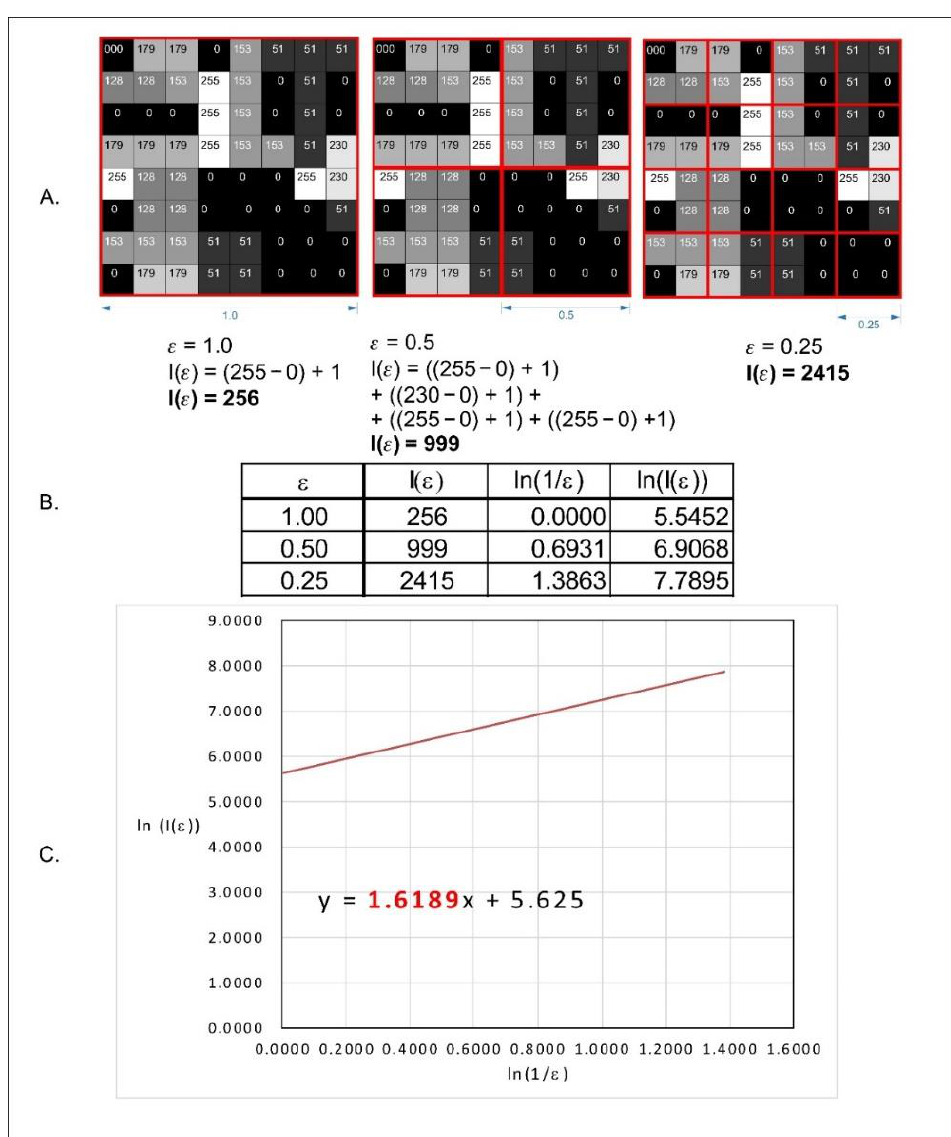
Figure 5. Graphical interpretation of the counting box method of fractal dimension counting. ( A )—analysed bitmap, dimension of analysed square size (ε) ( B )—Number of squares needed to cover the examined shape in the function of square size (ε). ( C )—a straight line drawn through points from table B on the x-y chart in decimal logarithm scale. The slope factor of this straight line is the value fractal dimension counted by the box method [32].